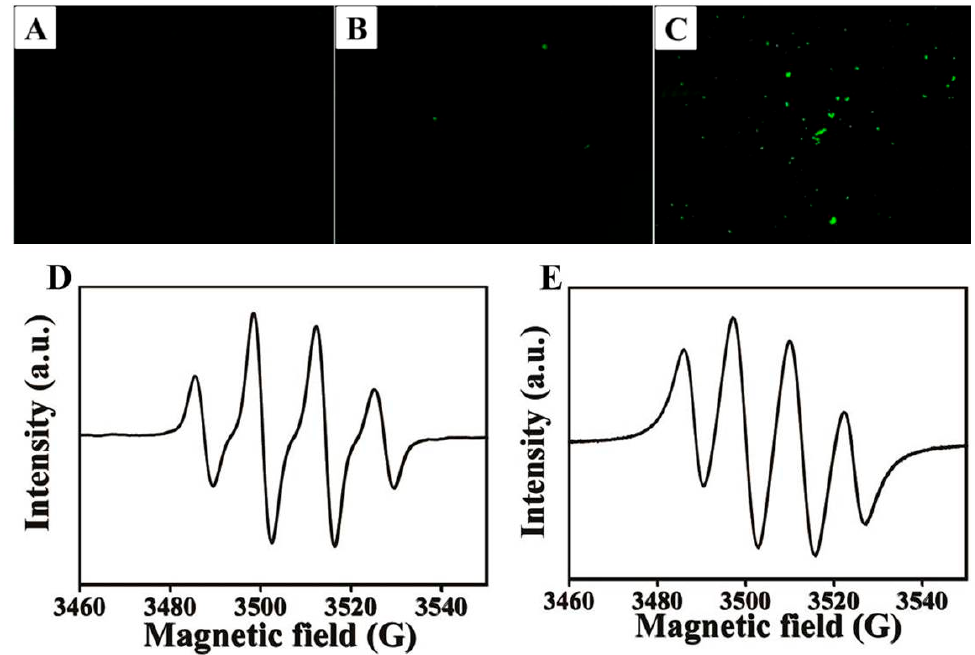
Figure 8. Reactive oxygen species (ROS) measurement of Salmonella cells. Fluorescence microscope images of pure MnO 2 nanosheets and DCFH-DA as a negative control ( A ). Fluorescence microscope images of untreated ( B ) and MnO 2 nanosheets-treated ( C ) Salmonella cells after staining with DCFH-DA. ESR images of DMPO − ·OH ( D ) and DMPO − ·O 2 − ( E ) for MnO 2 nanosheets.